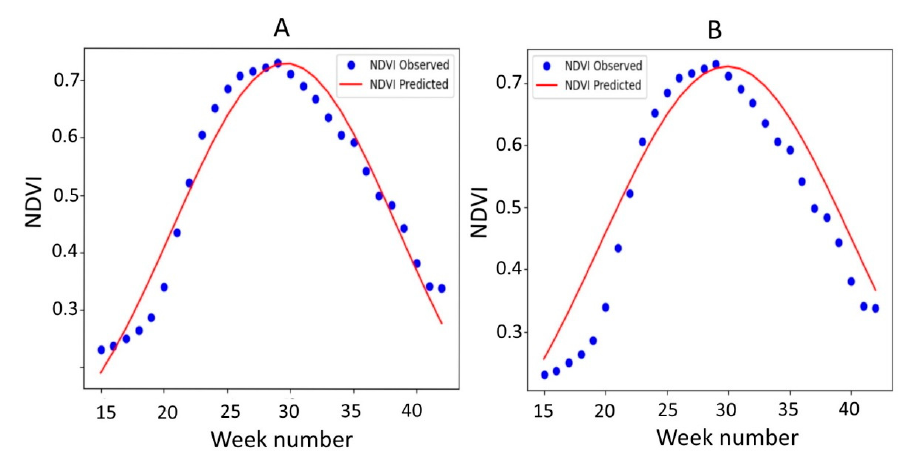
Figure 7. Actual and approximated values of the weekly NDVI composites for the arable land in the Khabarovsk District in 2019: ( A ) Parameters calculated from the NDVI composites in 2019; ( B ) parameters calculated from the averaged NDVI composites in 2014–2018.